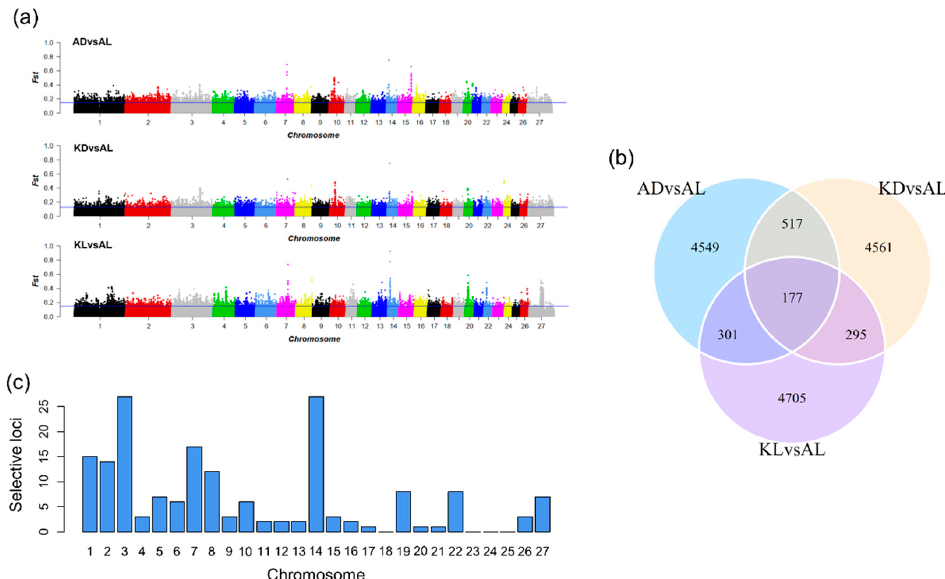
Figure 2. The selection signatures detected by Fst test. ( a ) Manhattan plots reflect the distribution of Fst scores between each population pairs (the top 1% suggestive line: ADvsAL, 0.15; KDvsAL, 0.13; KLvsAL, 0.15). ( b ) The venn plot indicates the counts of the top 1% signatures in each population pair and the overlap region represent the counts of common SNPs among three pairs. ( c ) The distribution of common SNPs on chromosomes. AD, Aldabas; AL, Aletai; KL, Karakul; KD, Kurdyuchnyj.